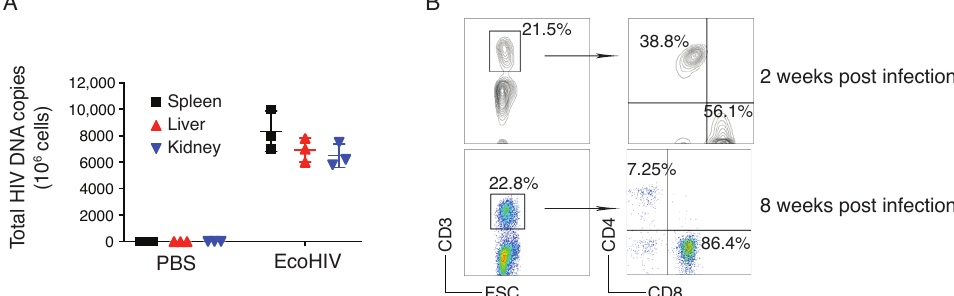
Figure 3. EcoHIV infection in mice. HHD mice were i.p. administrated with EcoHIV viruses. ( A ) Total HIV DNA copies. Three weeks after EcoHIV infection, the tissues of spleen, liver, kidney were isolated, and DNA was extracted for qPCR. Data shown are three individual experiments ( n = 5). The line represents mean values. ( B ). Analysis of CD4 + T cells in the spleens after EcoHIV infection. In weeks 2 and 8 after EcoHIV infection, single cell suspensions were made from the spleens and cells were analyzed for CD3 (left), and CD4 with CD8 were analyzed (right), gating on CD3 + populations by flow cytometry. Data are representative of three independent experiments ( n = 5).